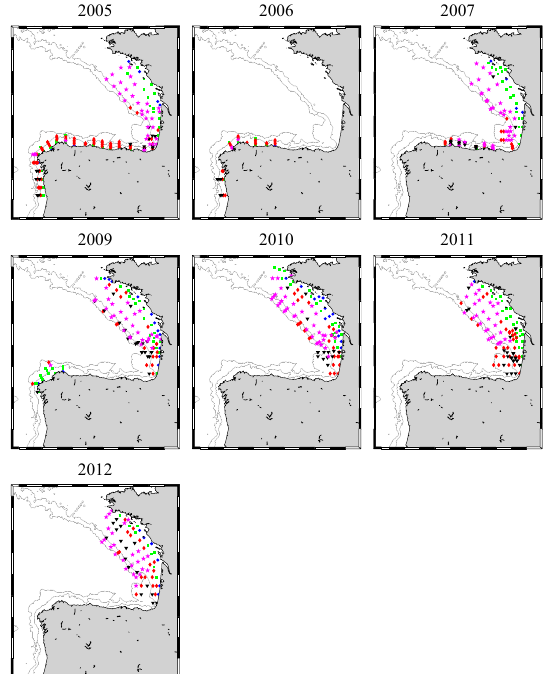
Figure 11. Spatial and interannual distribution of K means groups as established in Fig. 10 for the 7 years. Groups are represented by the same colors and shapes as in Fig.